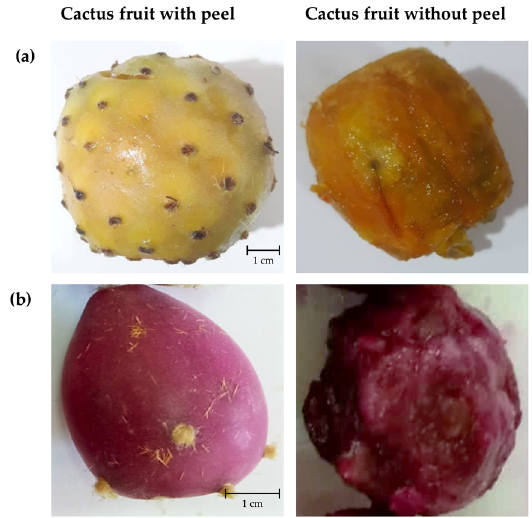
Figure 1. Photographs of Opuntia sp. fruits. ( a ) Cultivated Opuntia sp.; ( b ) Wild Opuntia sp. [photo- graphs of the author (W.Z.)] tographs of the author